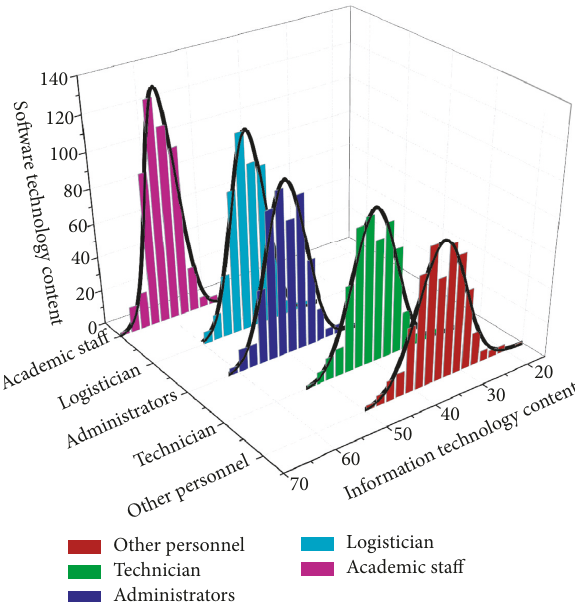
Figure 7: Curve of teaching personnel, management personnel, technicians, and logistics personnel applying information tech- nology and software